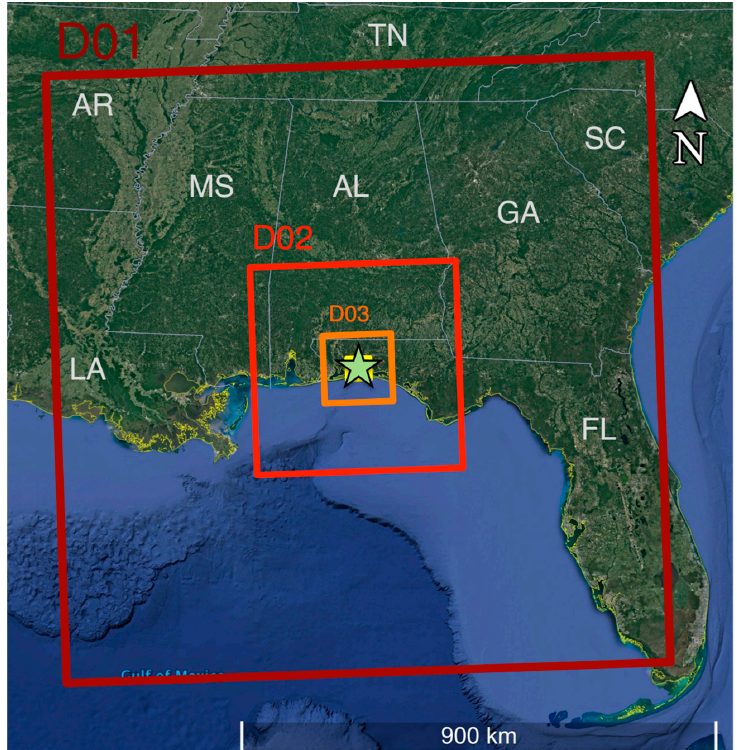
Figure 1. The Weather Research and Forecast (WRF) domain used for the RxCADRE L2F experiment. The horizontal grid spacing for each domain is as follows: 12-km (D01), 4-km (D02), and 1333-km (D03). The innermost domain (yellow) represents D04, which has a grid spacing of 0.444-km. Light green star denotes the location of Eglin Air Force Base. Map data: Google, DigitalGlobe.